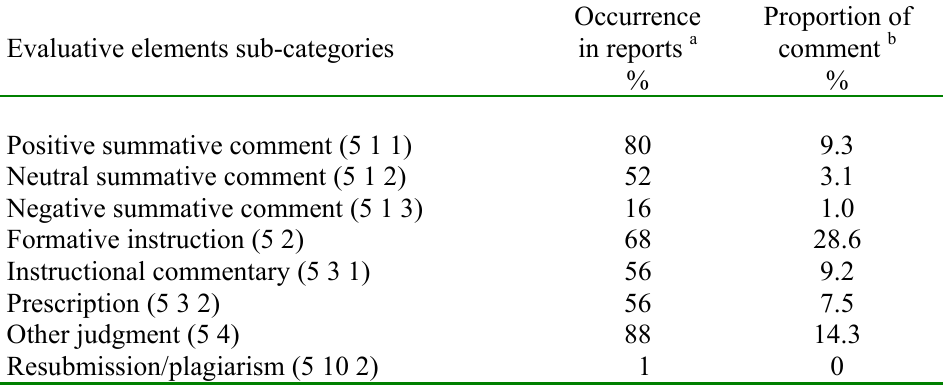
Table 2 : Evaluative elements - occurrence of comment and proportion of total report